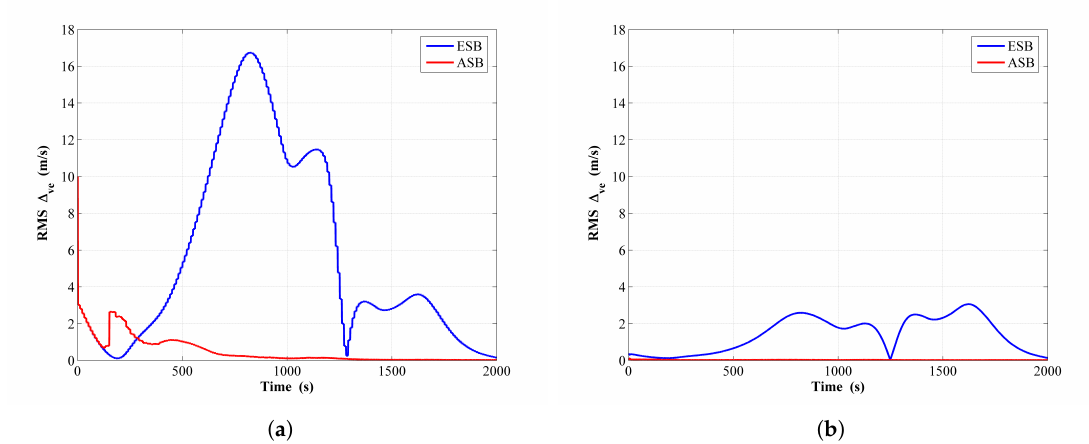
Figure 8. RMS of the ESV estimation error comparison between the ESB and the ASB algorithms using simulation data with unknown Q k : ( a ) Filter; ( b ) RTS smoother.